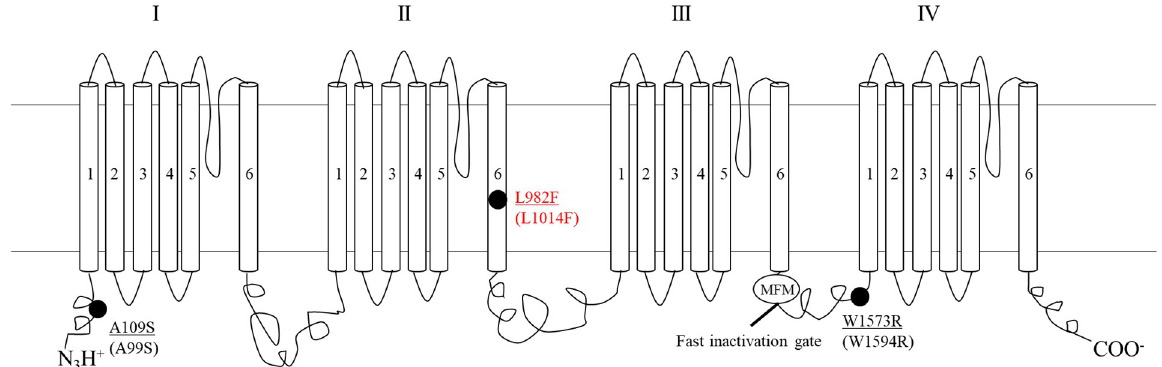
Fig 1. Pyrethroid-resistance associated SNPs in the voltage-gated sodium channel (VGSC, Na v ) of Culex quinquefasciatus . The solid circles represent non-synonymous mutations. Other synonymous mutations associated with resistance have been identified but are not shown here. For each mutation site shown, the top is the mutation site in Cx . quinquefasciatus . The bottom number (in parenthesis) is the mutation site in Musca domestica . The kdr -like mutation analyzed here is in red